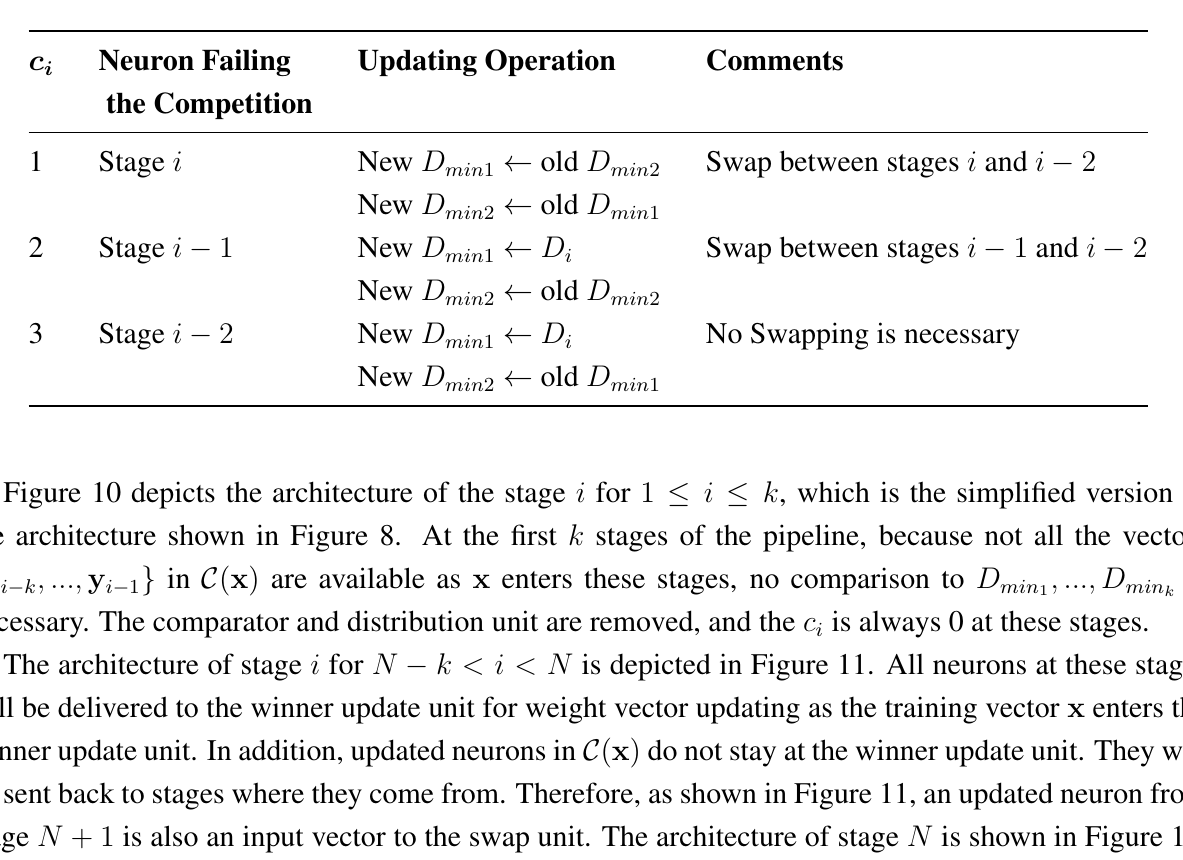
Table 2. The updating process of D k = 2